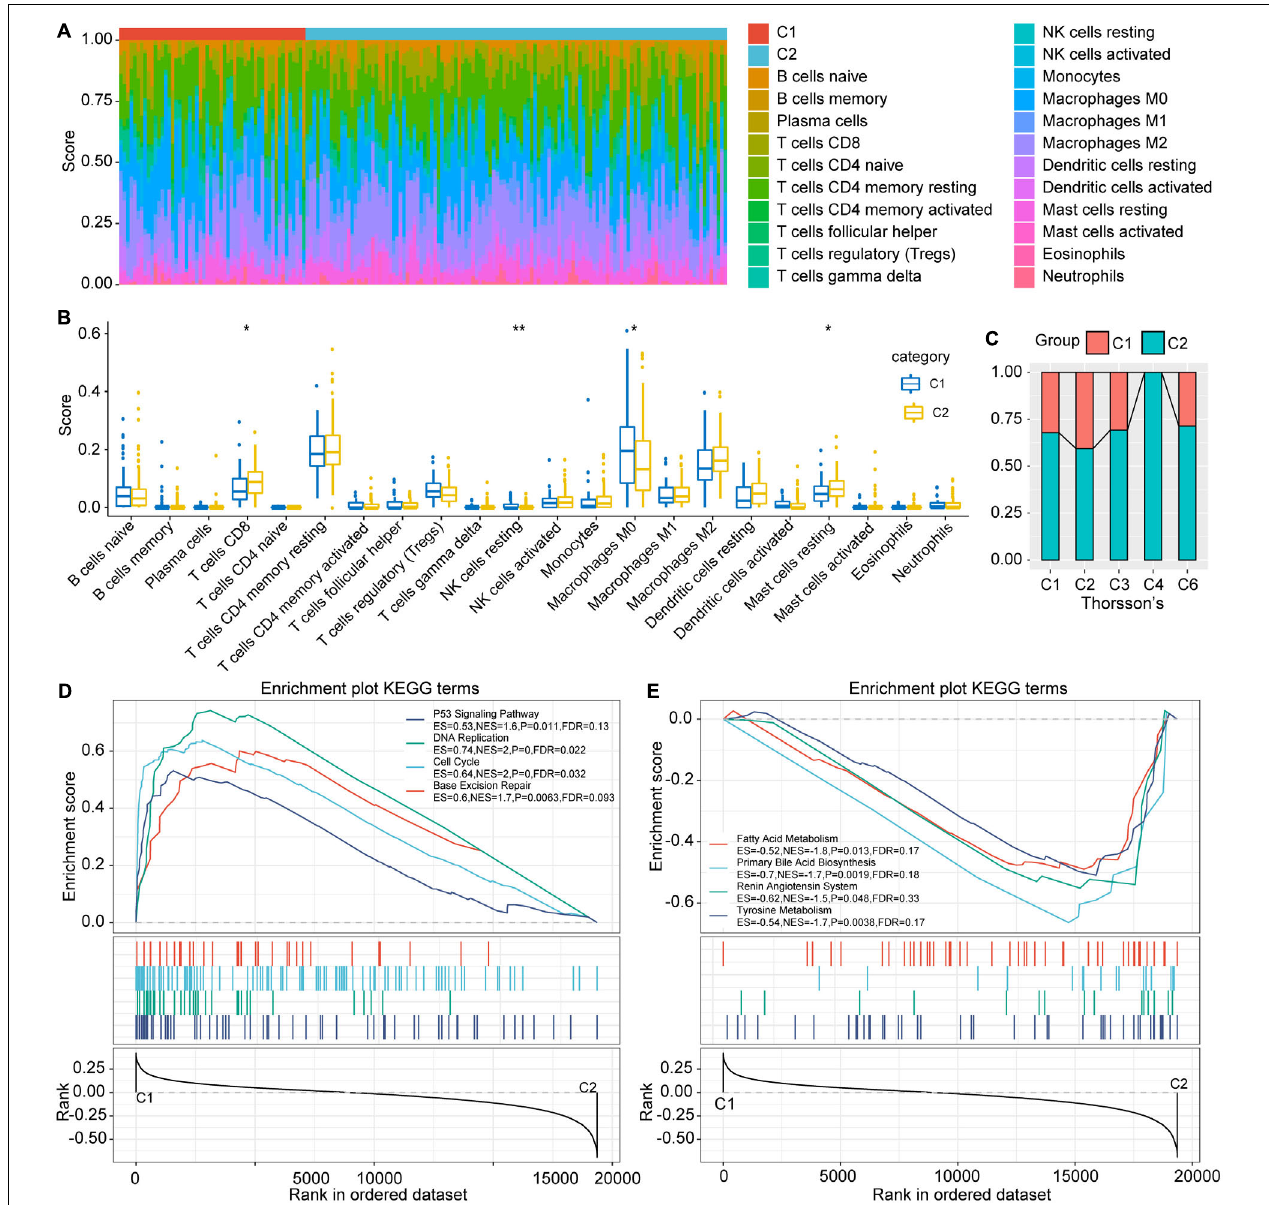
FIGURE 4 | Differences in immune cell characteristics between subtypes and GSEA. (A) Ratio of 22 immune cell components of the 2 subtype samples. (B) Differences in scores of 22 immune cells in samples between subtypes. (C) Intersection of C1 and C2 with the previous pan-cancer immune molecular subtypes. (D) The KEGG pathways enriched in C1 subtypes are mainly tumor-related pathways. (E) The KEGG pathways enriched in the C2 subtype are mainly metabolic related pathways, *indicates less than 0.05; **indicates less than